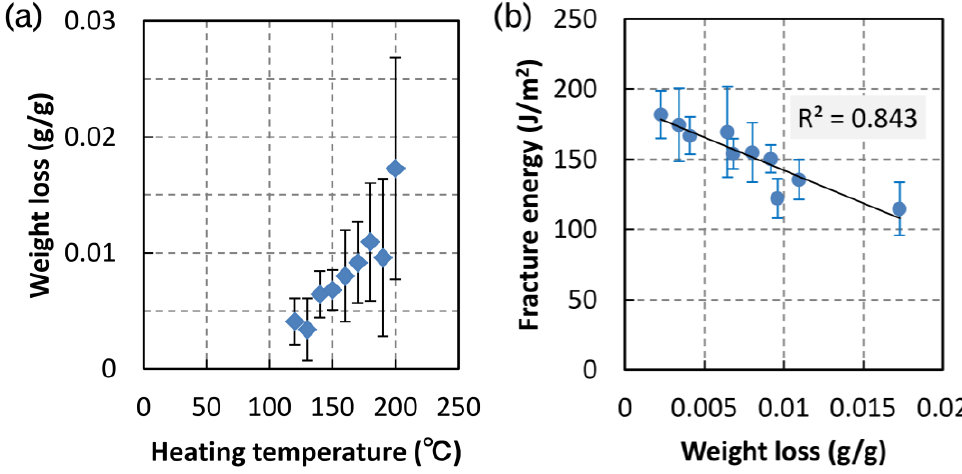
Figure 3. Effect of weight loss on fracture energy in tangentially loaded specimens; ( a ) weight loss by heat treatment and ( b ) fracture energy dependence on weight loss.